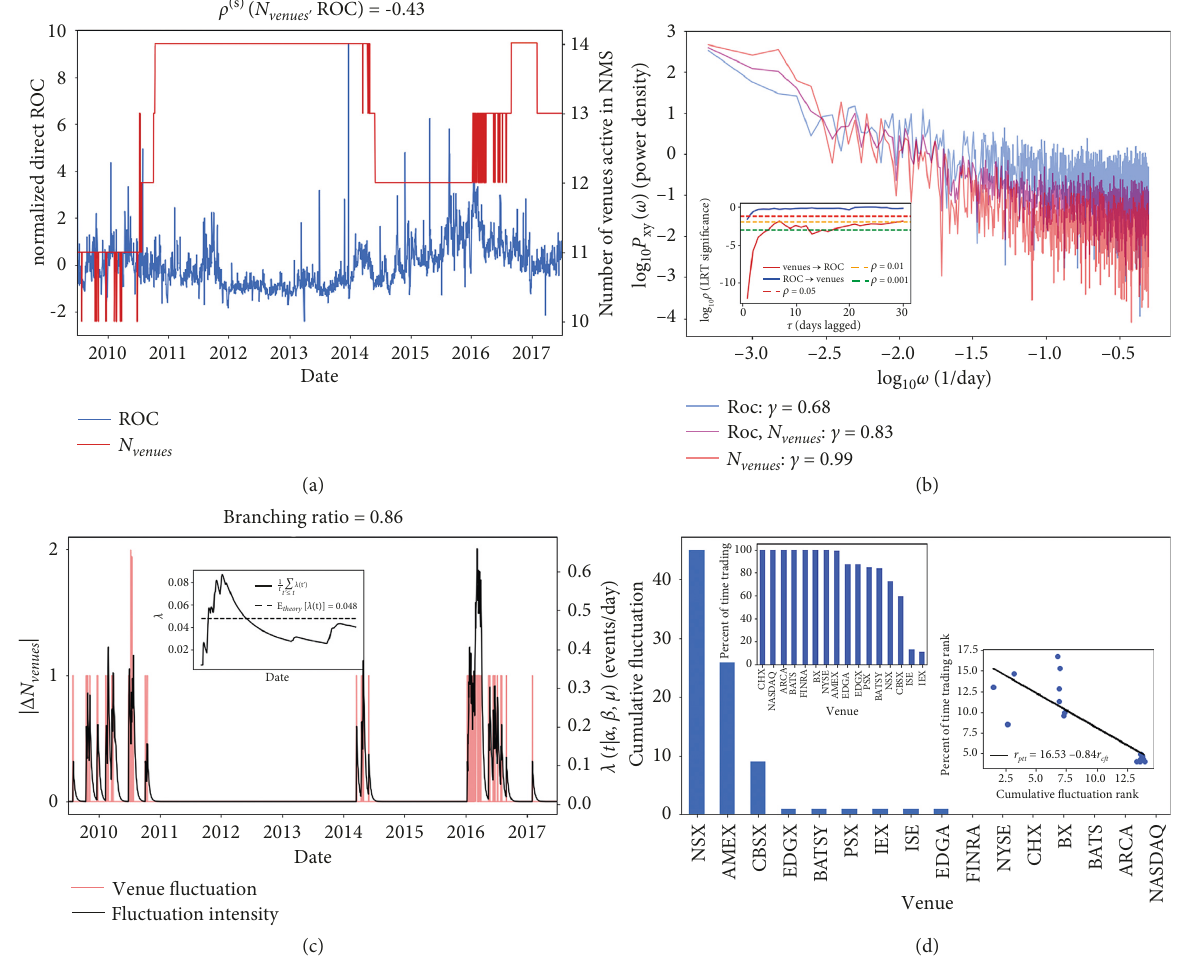
Figure 2: (a) The number of active trading venues and realized opportunity cost (ROC), normalized to have zero mean and unit variance, are negatively correlated. (b) Estimates of their power spectral densities allow for assessment of the stationarity of the time series. The inset demonstrates the granger-causal relationship between venues and ROC (venues ⟶ ROC). (c) The time series of fluctuation in the number of trading venues and the latent intensity time series of a hypothesized Hawkes process model for venue fluctuation. The inset panel displays the convergence for this model. (d) Cumulative fluctuation for each exchange over the study period. The first inset plot shows the total percent of time under study that each venue was active, and the second inset plot displays a negative association between fluctuation and total percent of time that a venue was